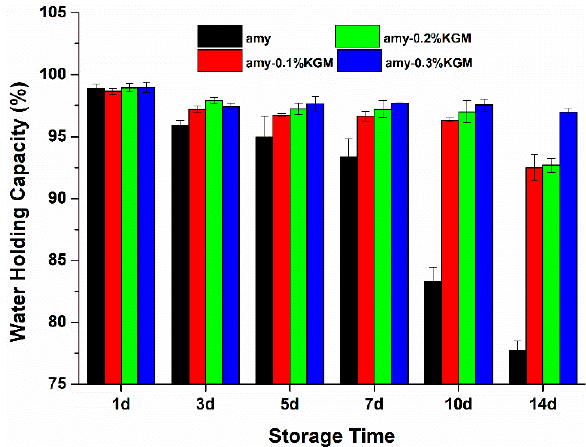
Figure 5. Water-holding capacity of amylose–KGM mixtures at different storage times.